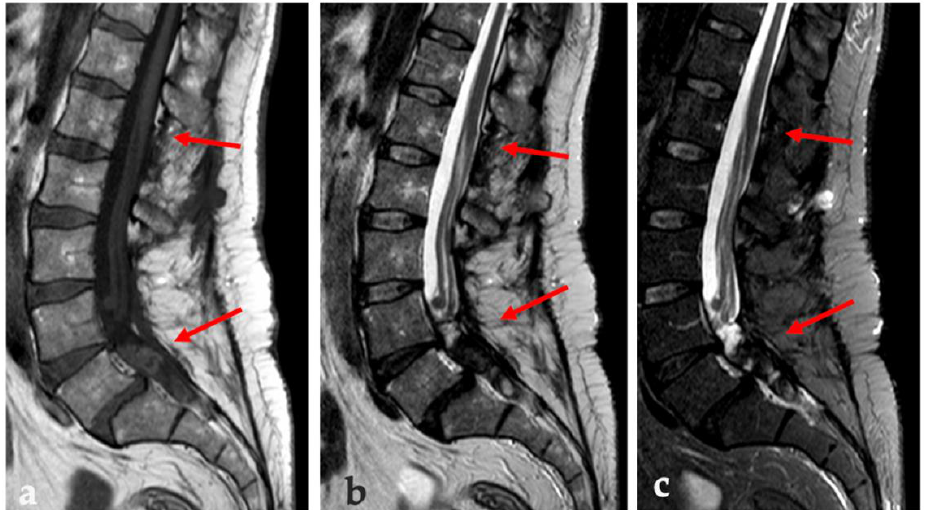
Figure 2. On T1w ( a ), T2w ( b ), STIR ( c ) sequences is shown a thickening of the roots of the cauda with a pseudo-nodular appearance and a tissue component extending from L4 to S2 (the upper and caudal ends of the lesion are pointed by the